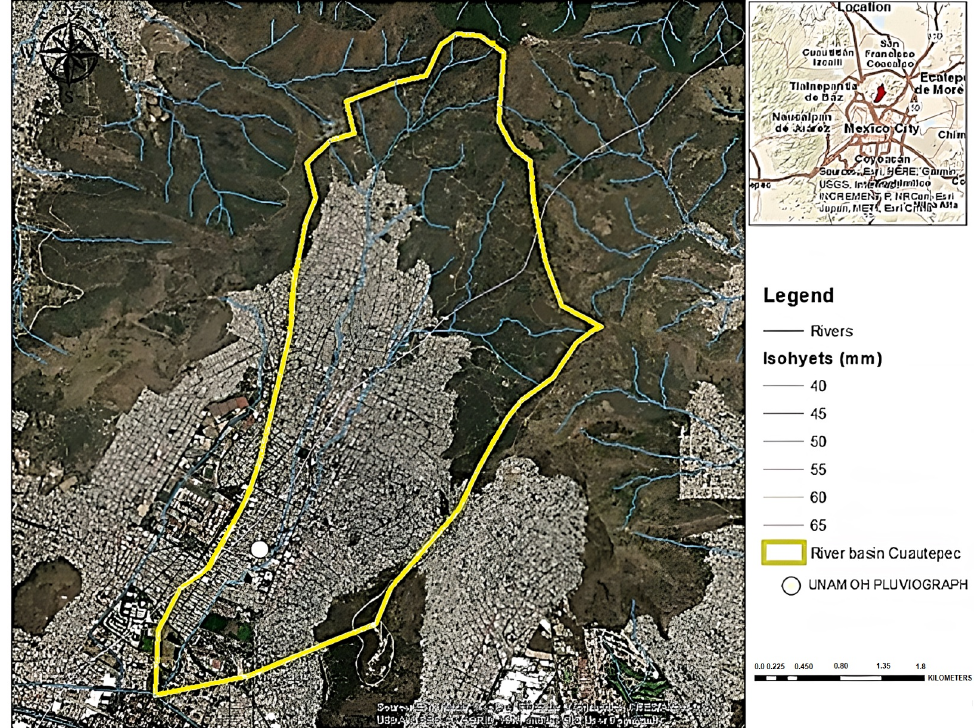
Figure 2. Location of the study site and the pluviograph of the OH, UNAM.